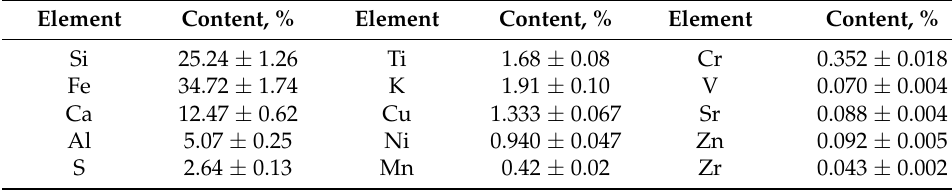
Table 2. Results of the investigation of the chemical composition of CNO.